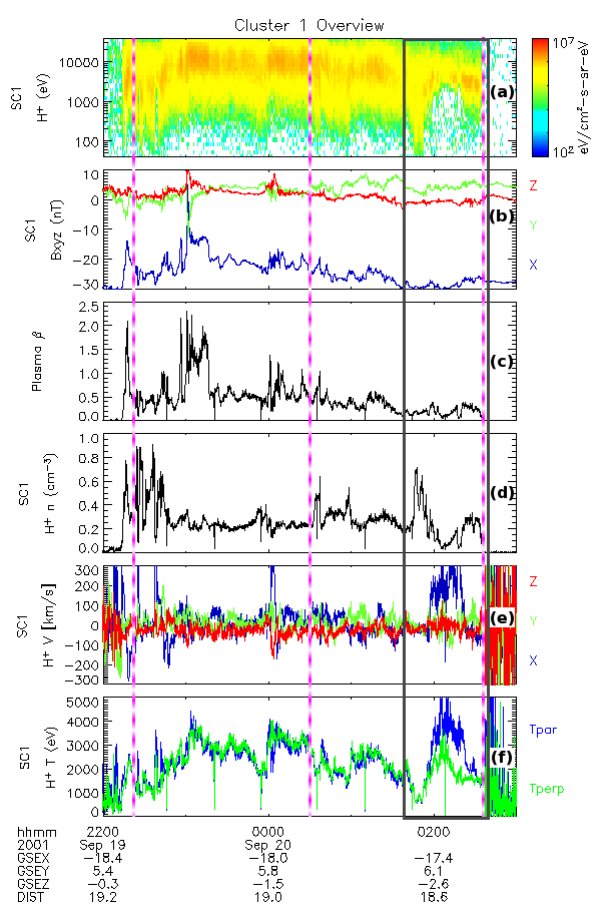
Fig. 3. Overview of 5h of Cluster 1 data, measured in the southern plasma sheet. From top to bottom: (a) CIS/CODIF proton energy spectrogram. (b) Magnetic field. (c) Plasma β , equal to the ratio of proton to magnetic pressure. (d–f) Plasma density, velocity, and temperature, as derived from the proton data. The conjunction times are indicated by magenta vertical lines. The rectangle shows the interval investigated in this paper. The interval 22:00–01:30 UT is discussed in